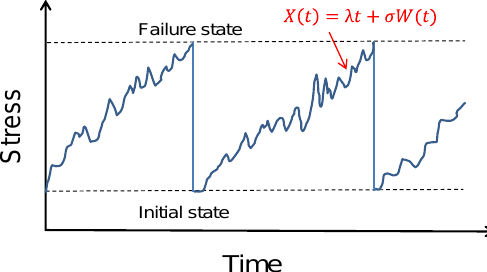
Figure 2. Schematic diagram showing the essentials of the Brow- nian model; within the two imaginary stress states, the model con- siders the stress–time series should be random and can be mod- eled by a long-term stress increment and a Brownian motion as X(t) = λt + σW(t) , where X(t) is the stress at time t , λ is the long- term stress increment rate, and σ is the magnitude of a Brownian motion W(t)